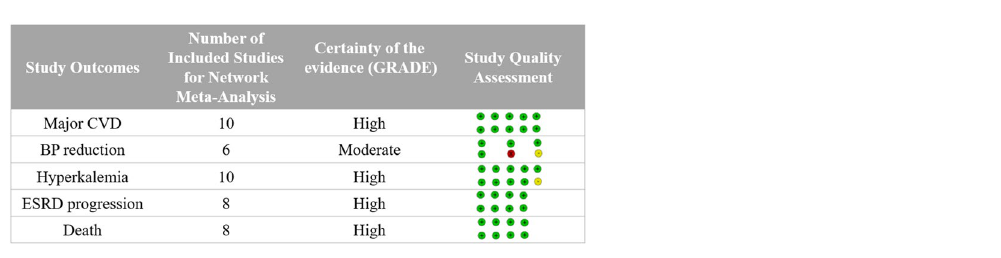
Figure 3. Quality Assessment of Included Studies and